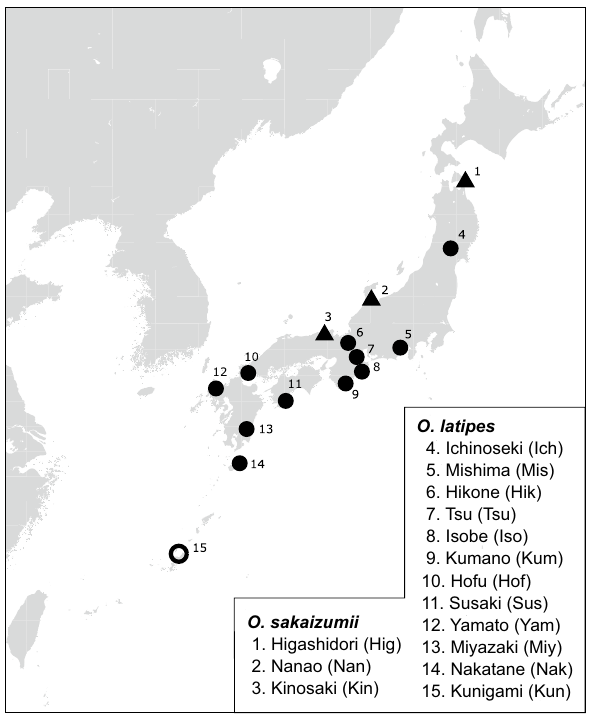
Figure 3. Geographic locations of collection sites. Filled circles and triangles on the map represent O. sakaizumii and O. latipes , respectively. The open circle represents a new collection site for wild medaka. The numbers and abbreviations correspond to the names in Table S11. The map was generated by GMT, Generic Mapping Tools